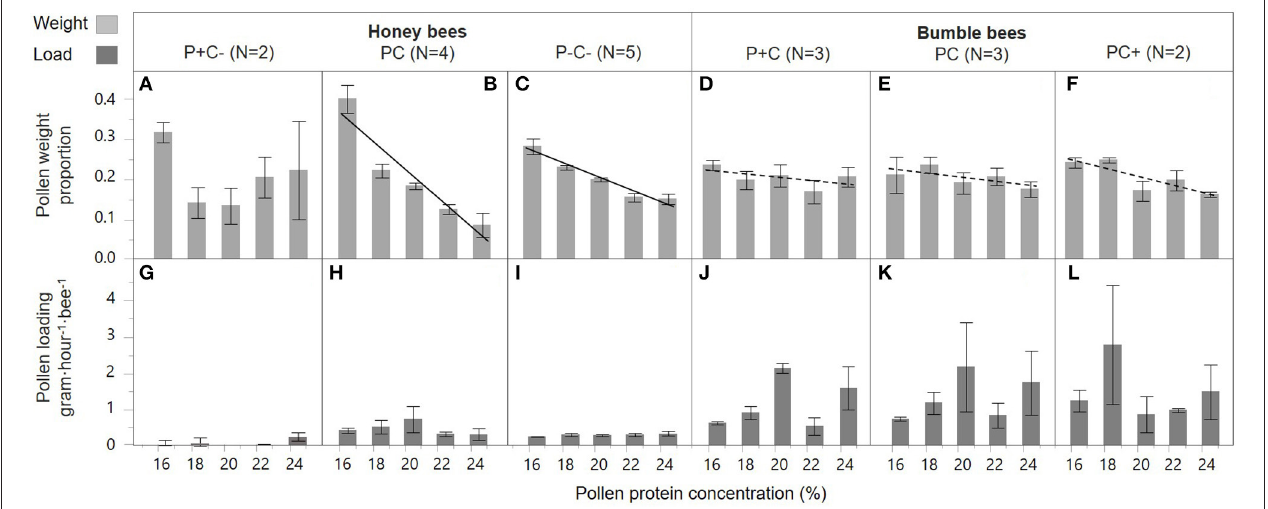
FIGURE 3 | Honey bee and bumble bee preference during pollen collection. With the pollen diet protein concentration in percent on the x-axis, relative pollen collection by individual bees is shown as weight proportions on the y-axis (A–F) , and pollen loading on the y-axis (G–L) . Trendlines indicate dose-response significance per treatment, involving protein (P) and carbohydrate (C) manipulations, within honey bee colonies (left side) and bumble bee colonies (right side). The striped trend lines indicate a significant dose-response for bumble bees in general, albeit this effect was insignificant for the treatment groups